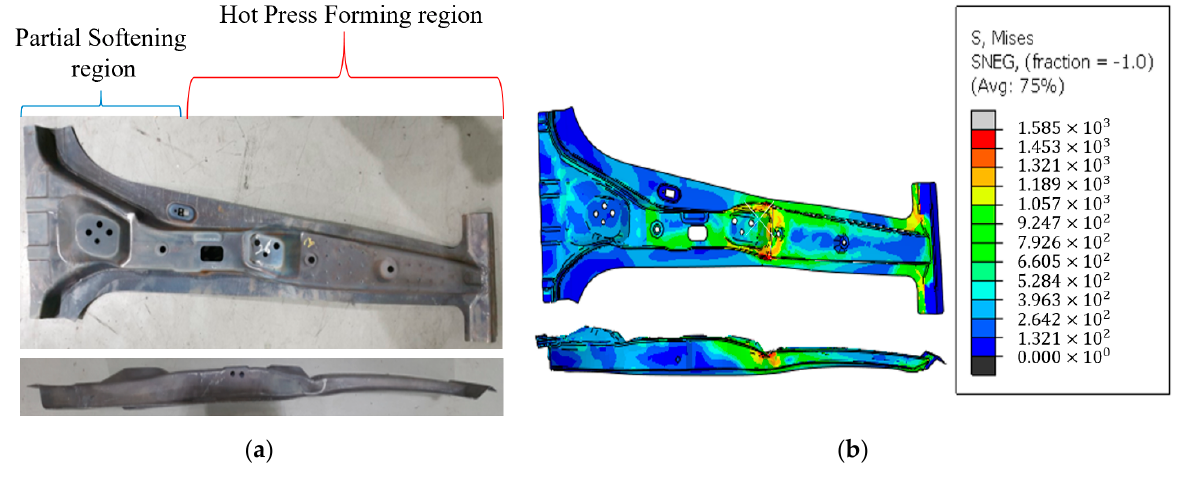
Figure 9. Comparison of the HPF center pillar with PW and PS after the drop weight test: ( a ) top and side view after the experiment; ( b ) top and side view after the simulation [20].